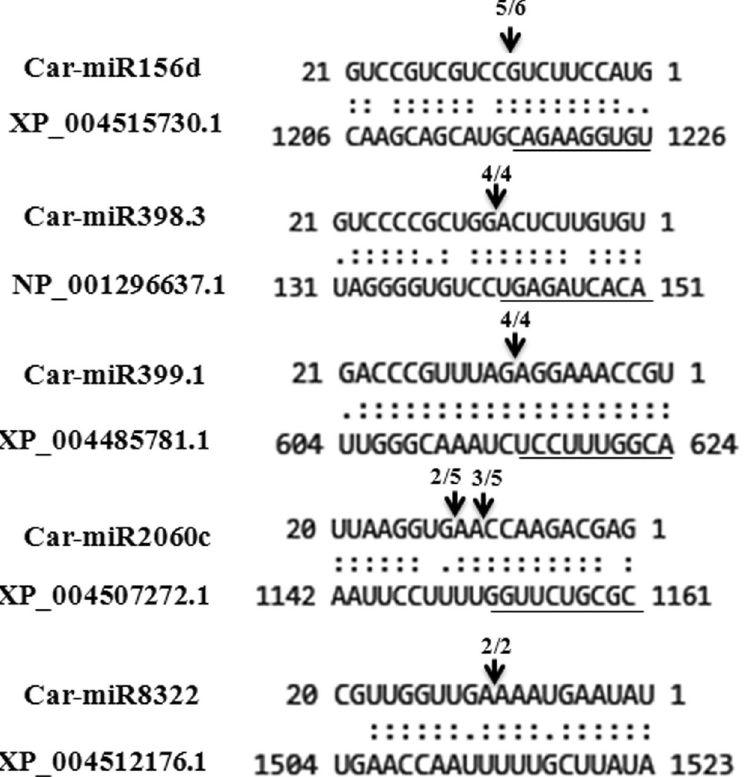
Figure 5. Determination of target gene cleavage site by degradome sequencing. Cleavage sites of six miRNA- target gene combinations are shown by aligning the corresponding mRNA ans miRNA sequences. Arrows mark the cleavage sites as determined by the sequencing of the 5 ′ RLM-RACE products shown below in each